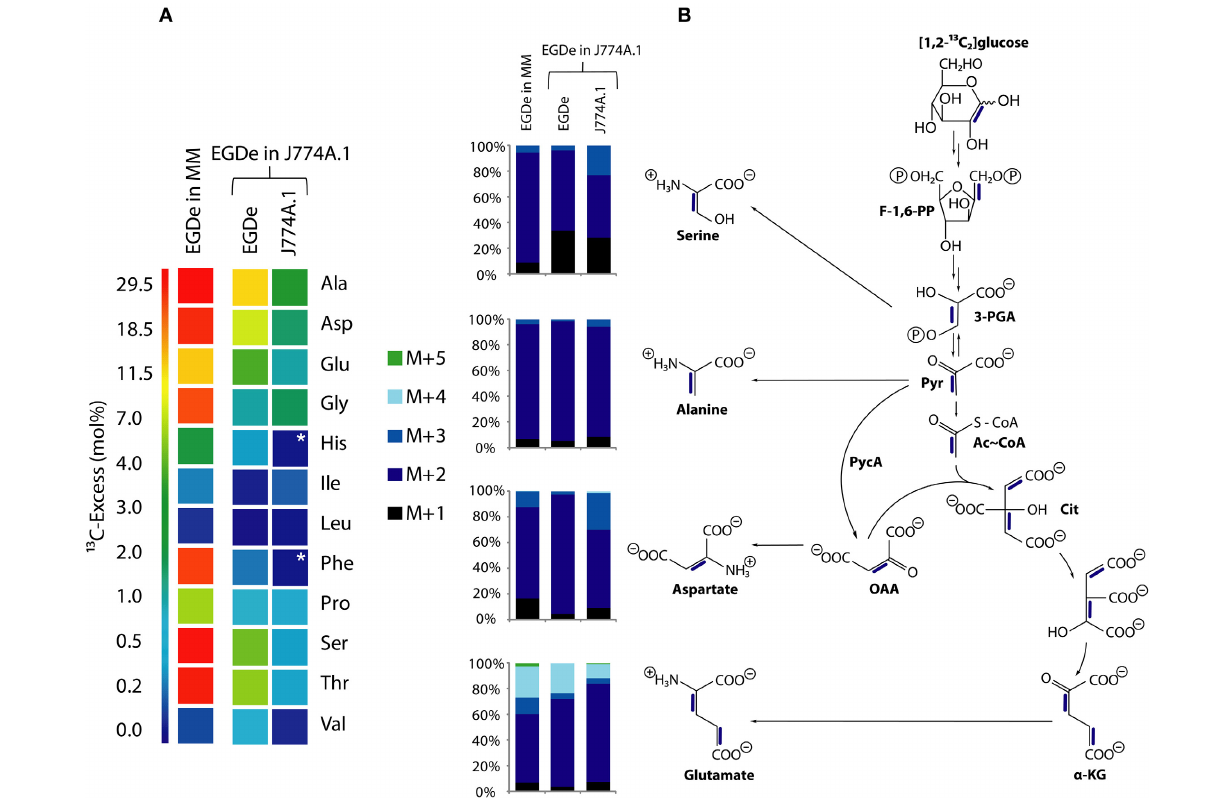
FIGURE 5 | Analysis of protein-derived amino acids from L. monocytogenes EGDe in the experiments with [1,2- 13 C 2 ]glucose. (A) 13 C-excess (in % as a color map) of L. monocytogenes EGDe grown in minimal medium (MM) in the presence of 10mM [1,2- 13 C 2 ]glucose (column 1) of from L. monocytogenes EGDe grown in J774A.1 cells in the presence of 10mM [1,2- 13 C 2 ]glucose. Boxes with white asterisks indicate high standard deviations in the measurement of the overall